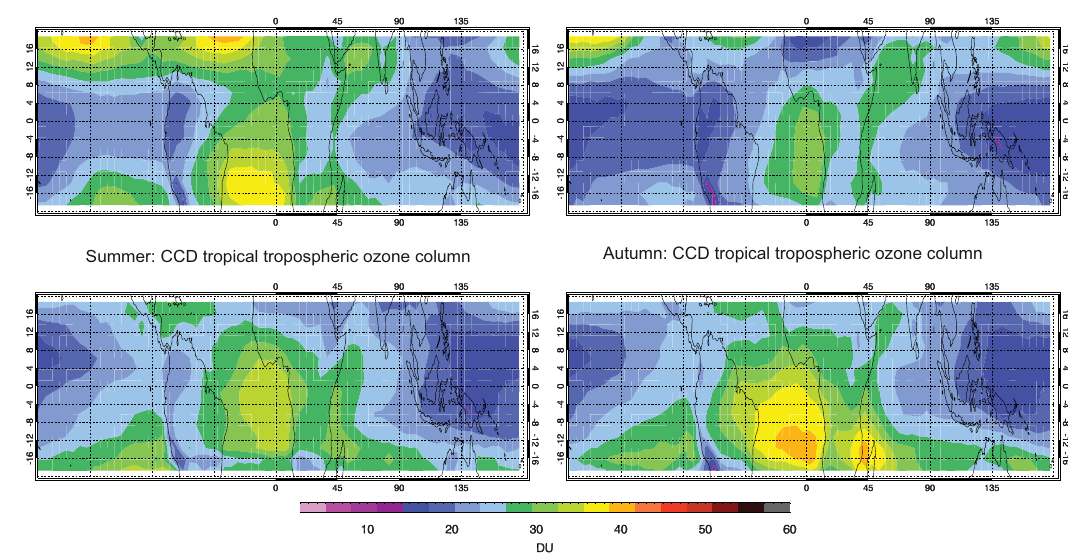
Figure 8. Seasonally averaged tropical tropospheric ozone column (TTCO) derived with the convective cloud differential (CCD) technique, From all instruments, between 1996 and